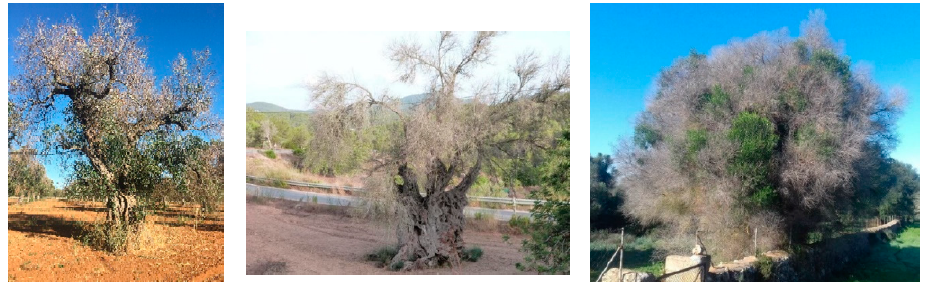
Figure 3. Cultivated olive and wild olive trees infected by different genotypes of X. fastidiosa in Europe. Left, olive tree infected by ST53 subsp. pauca in Apulia, Italy; center, dead olive tree infected by ST80, subsp. pauca in Ibiza, Spain; right, wild olive tree showing severe dieback caused by ST81 subsp. multiplex in Mallorca.